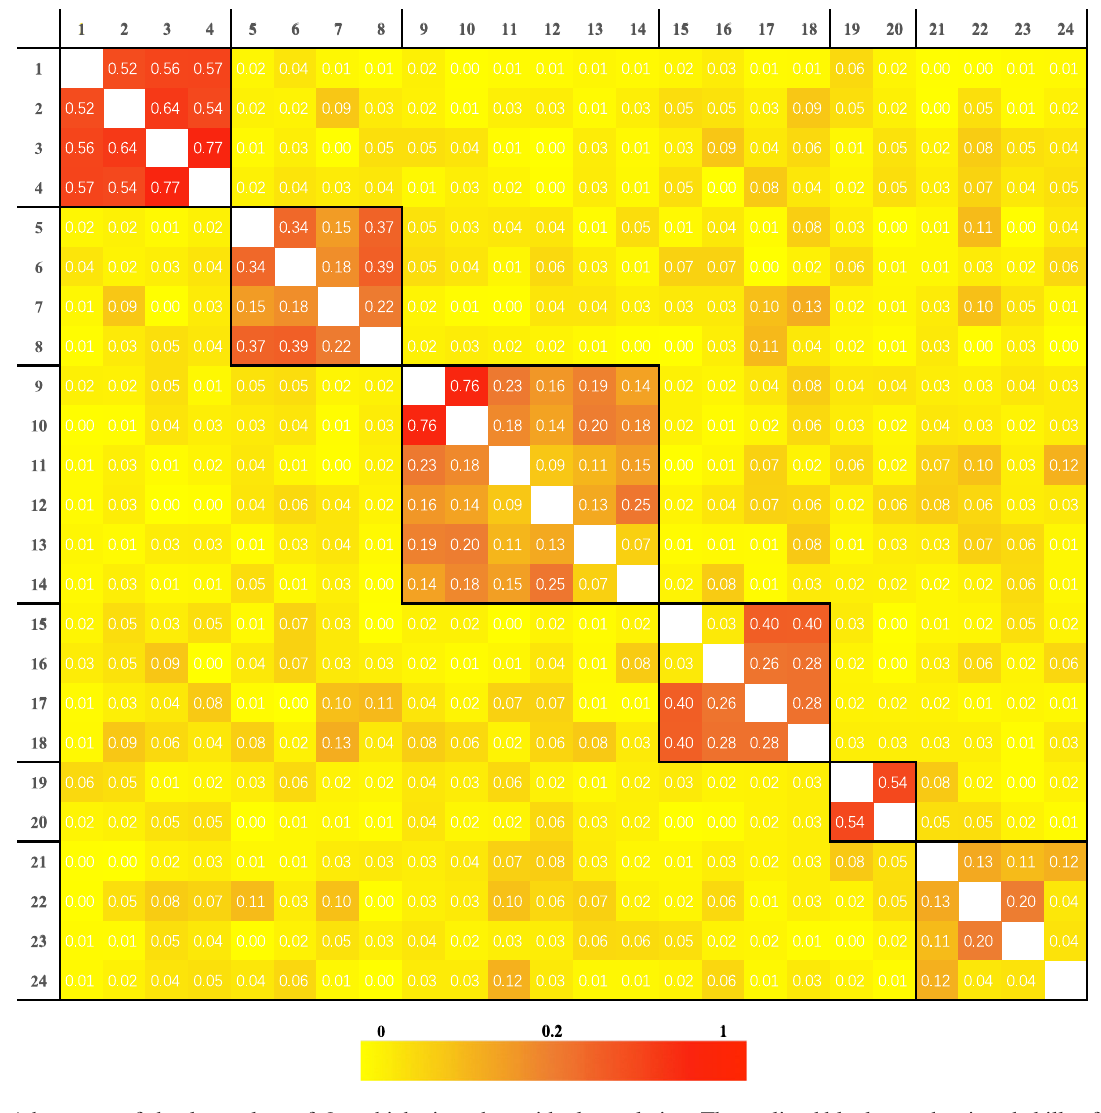
FIG. 5. A heat map of absolute values of Q 3 , which gives the residual correlation. The outlined blocks are the six subskills of scientific reasoning (see Table I). The heat map ’ s color transition is nonuniform with the median set at 0.2, which is the recommended Q 3 value for showing a correlation as suggested by Chen and Thissen